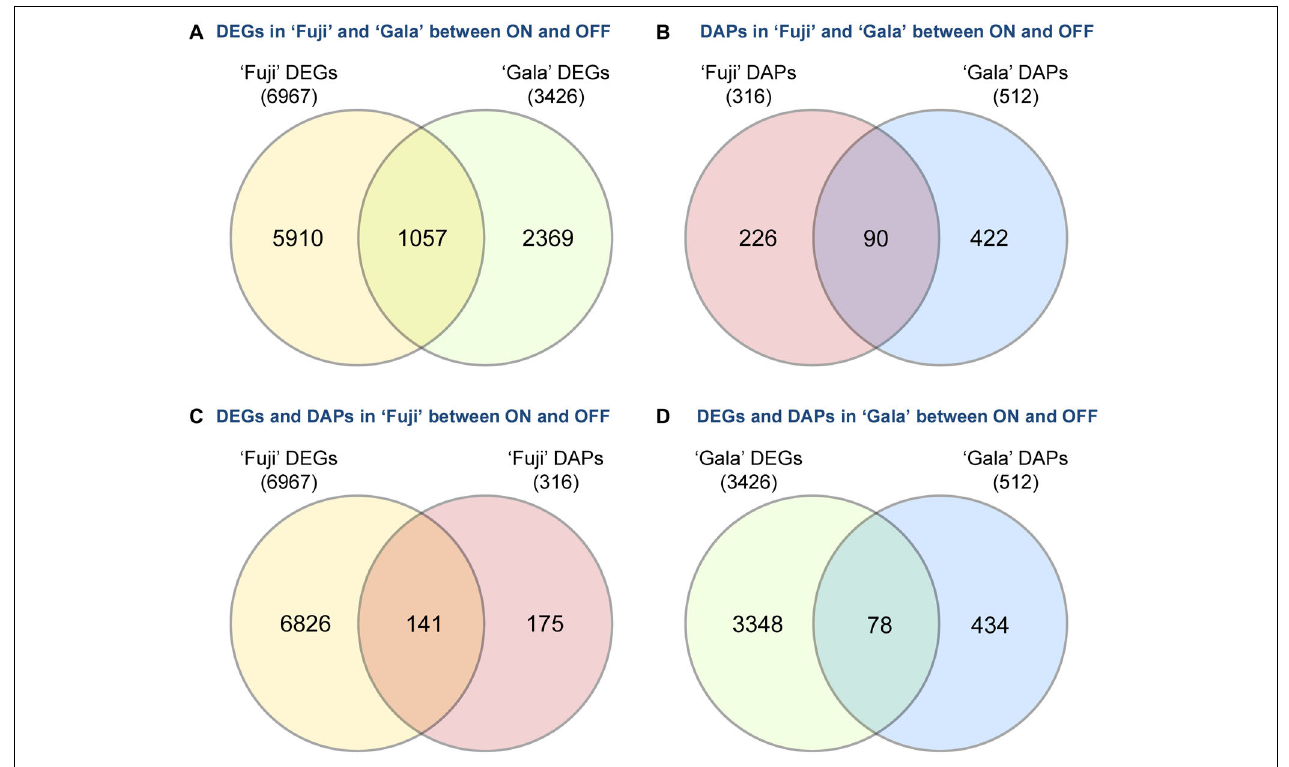
FIGURE 3 | Crop load (ON, OFF)-induced number of differently expressed genes (DEGs) and differentially abundant proteins (DAPs) between (A,B) and within (C,D) the cultivars ‘Fuji’ and ‘Gala’ during 1–4 weeks prior to flower